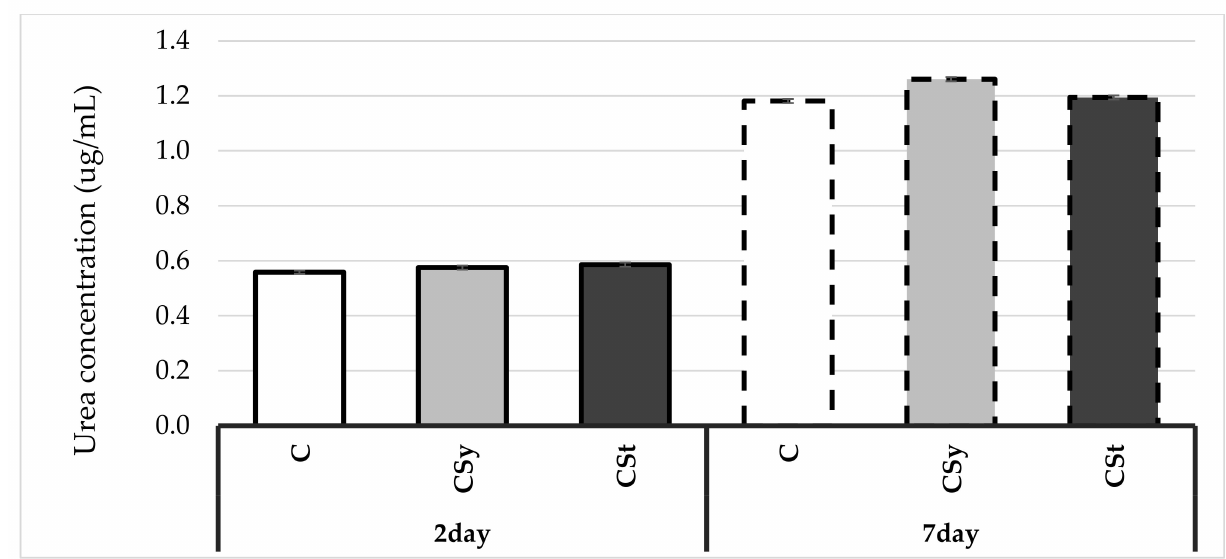
Figure 6. Urea concentrations in the 2- and 7-day-old workers’ hemolymph after two methods of supplementation with hemp extract (Two-Way ANOVA: supplementation method: F (2,59) = 23.004, p = 0.000; days of supplementation: F (1,59) = 11912.0, p = 0.000; supplementation method*days of supplementation F (2,59) = 15.560, p = 0.000). C–control (pure sugar syrup), Csy–hemp extract in syrup, Cst–hemp extract on